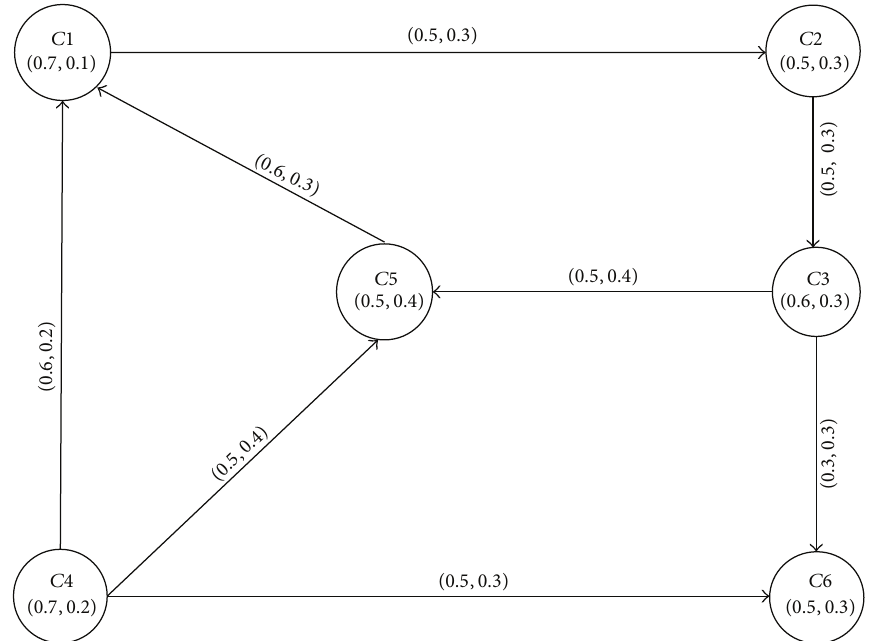
Figure 4: Intuitionistic fuzzy digraph of a gas pipeline